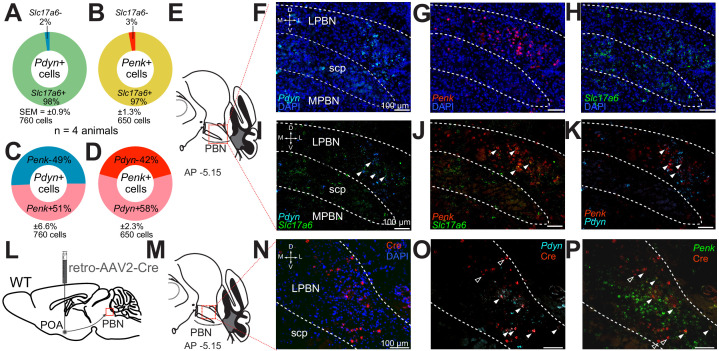
Pdyn+ and Penk+ LPBN neuron populations overlap, express Slc17a6, and project to the POA.(A–D) Quantification of cells labeled with (A) Pdyn probe (Pdyn+) and Slc17a6 (VGLUT2+) probes, or (B) Penk (Penk+) and Slc17a6 (VGLUT2+) probe, or (C and D) Pdyn and Penk probes. (E) Illustration of area of parabrachial nucleus (PBN) depicted in F–K. (F–H) Representative FISH images of LPBN neurons expressing (F) Pdyn, (G) Penk, and (H) Slc17a6. (I–K) (similar results were obtained in n = 3 mice) Representative images of overlays of (I) Pdyn with Slc17a6 and Penk with Slc17a6 (J), and (K) Pdyn with Penk. Arrowheads mark examples of cells positive for co-labeling of two transcripts. 98% of neurons expressing Pdyn and 97% of neurons labeled for Penk were also labeled with probes for Slc17a6. Data are presented as mean ± SEM; n = 4 animals, 760 cells for Pdyn and n = 4 animals, 760 cells for Penk. Diagram of viral injections into wild-type mice. (M) Anatomical location of representative FISH images shown in (N and O) that show overlap of (N) Cre expression, mediated by retrovirus transduction, with (O) Pdyn and (P) Penk. Arrowheads mark cells expressing Cre, with filled arrowheads co-expressing (O) Pdyn or (P) Penk and open arrowheads only expressing Cre.